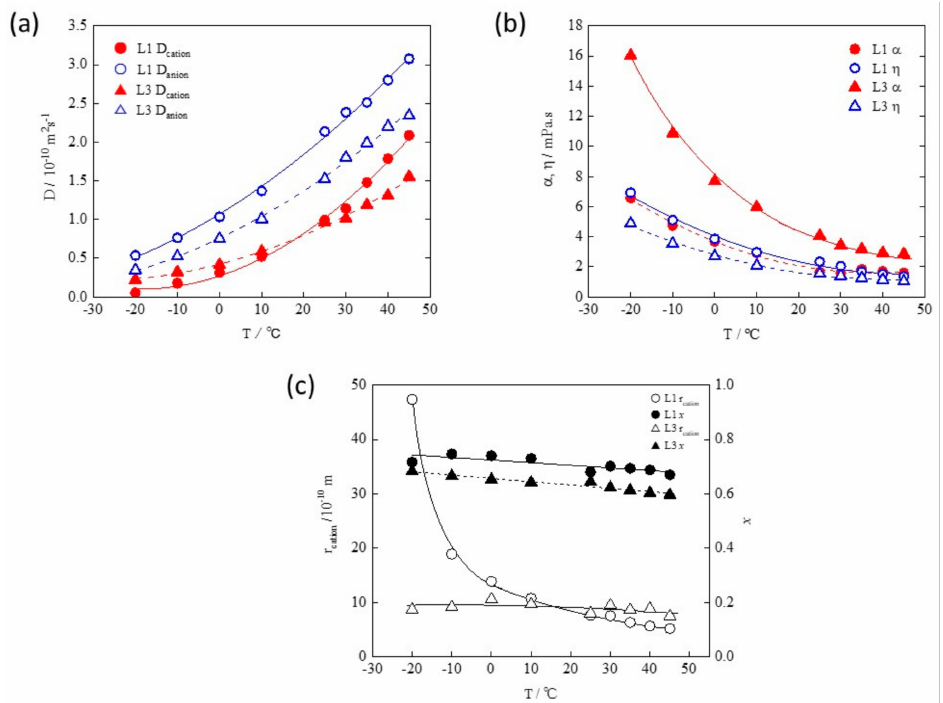
Figure 4. Temperature dependences of ( a ) D cation and D anion , ( b ) η and α , and ( c ) r cation and x of L1; 1 M LiPF 6 /EC+DEC (EC:DEC = 1:1) and L3; 1 M LiPF 6 /EC+DEC (EC:DEC = 1:6.9) solutions without the separator membrane. Reprinted with permission from [24]. Copyright 2017 ACS